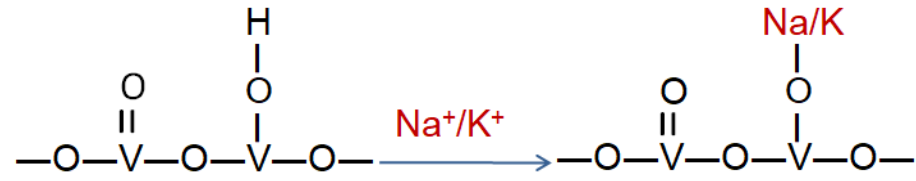
Figure 2. The mechanism of V 2 O 5 -TiO 2 catalyst deactivation by alkali metals (based on Reference [45]).